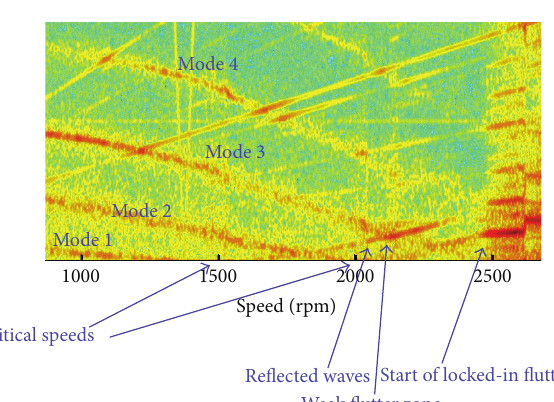
Figure 2: Deflection of the disk, during idling run-up from 0 to 3600 rpm, measured by displacement probe.